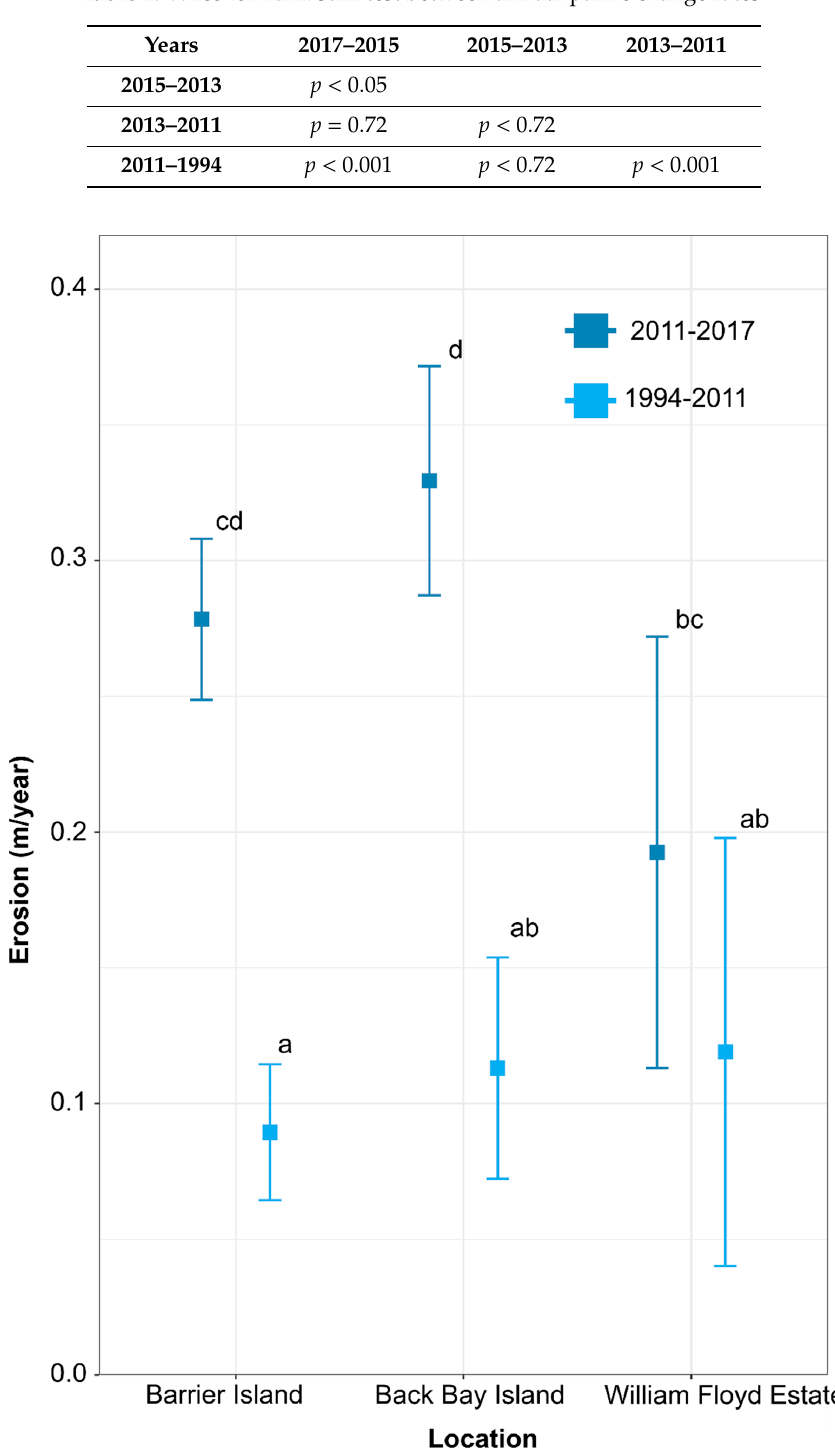
Figure 6. Edge erosion rates compared by time period (1994–2011, 2011–2017) and location (barrier island, mainland, or back bay island) with least square means with Bonferroni p -value adjustment. Location/dates that share letters did not demonstrate significant differences ( p > 0.05). Table 4. Wilcoxon rank sum test between annual panne change rates.